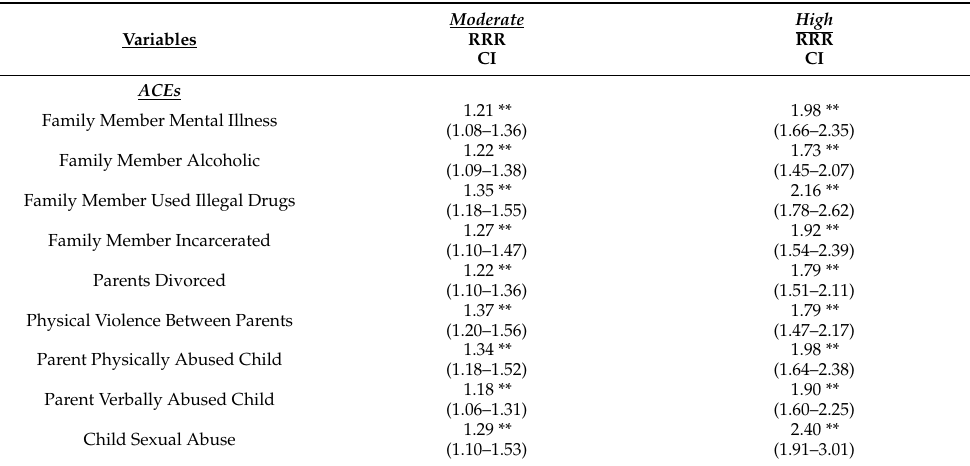
Table A3. Multinomial logistic regression models of the association between individual ACEs and cardiovascular risk among young adults ( n =